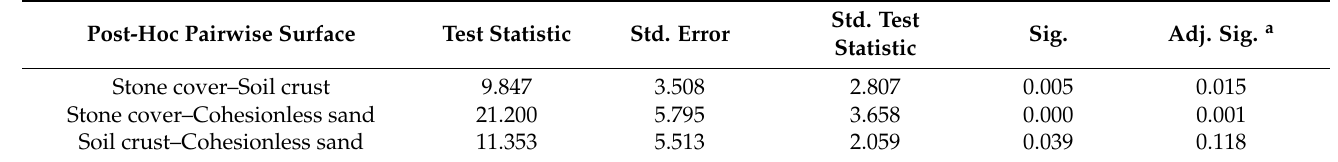
Table 5. Pairwise comparisons surface.